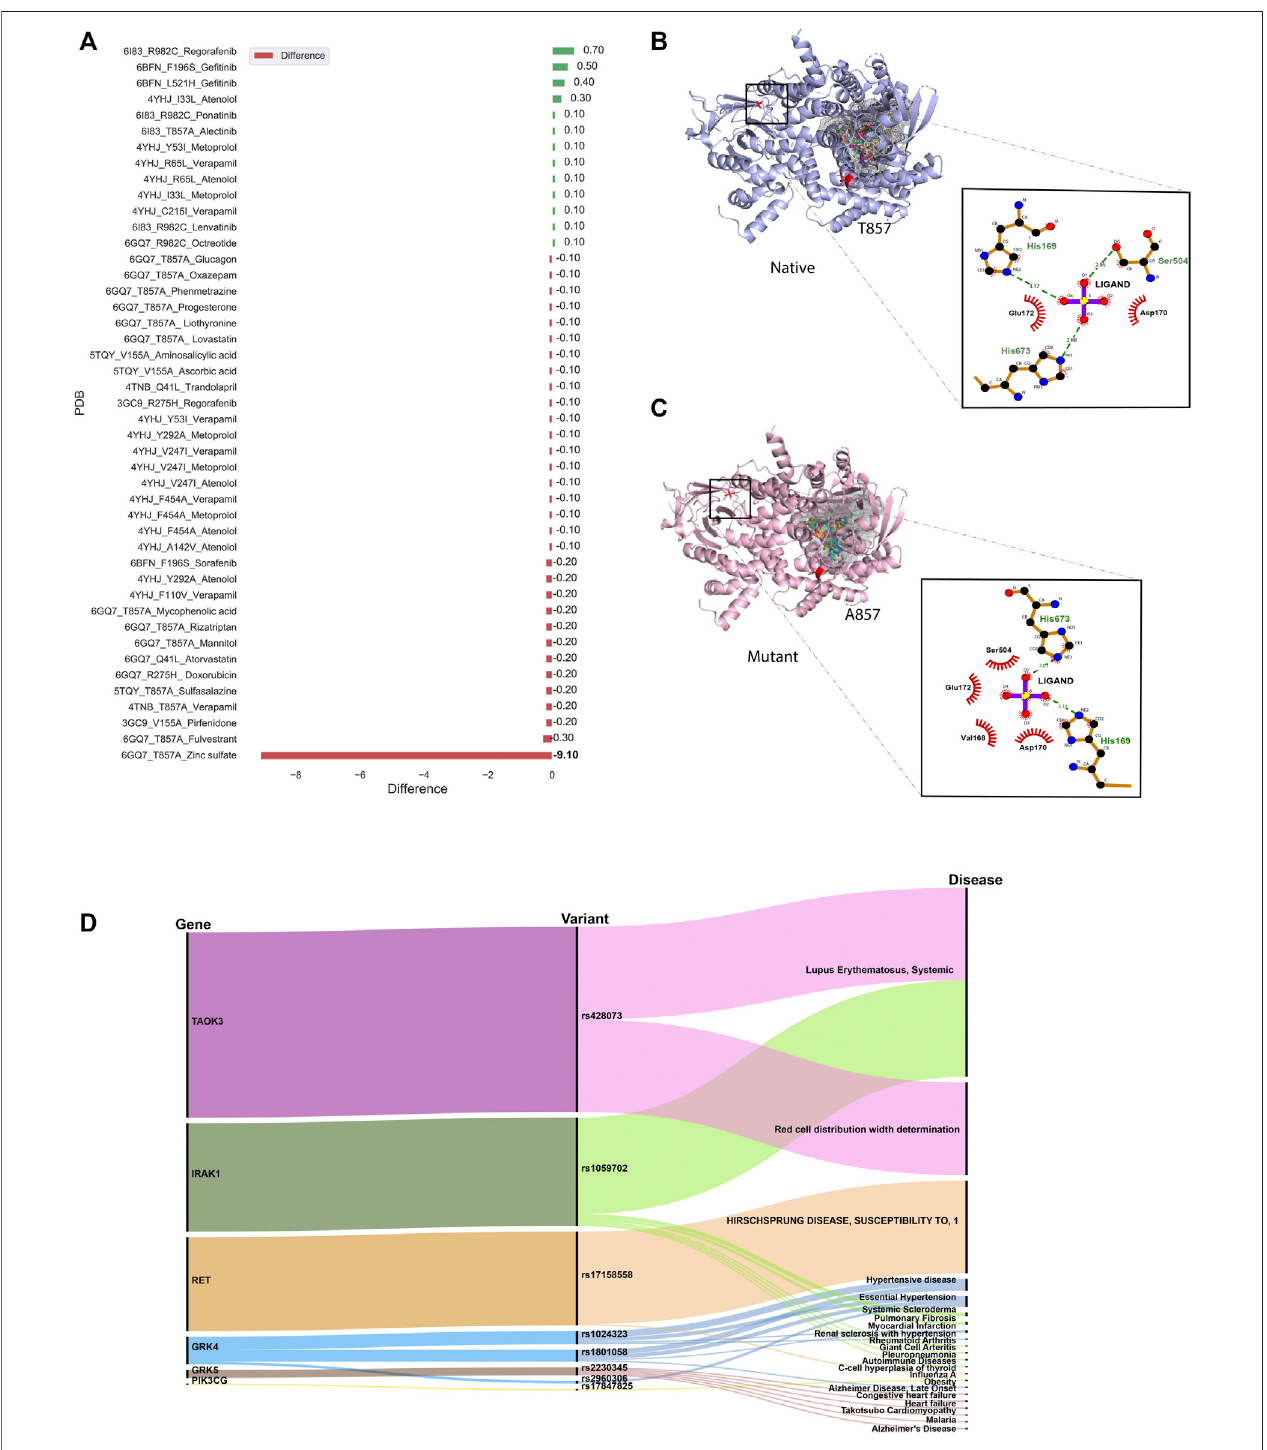
FIGURE5|(A) Barplotshowingdocking resultsfor45protein-drugpairs onthex-axis andchangeinbindingaf fi nityobservedonthey-axis.Redbars represent a decreaseinbindingaf fi nityandgreenbarsrepresentanincreaseinbindingaf fi nityaftermutation. (B) Ligandinteractiondiagramofnative6GQ7(PIK3CGgene)boundto Zinc Sulfate (DB09322) . (C) Ligand interaction diagram of mutant T857A of PIK3CG gene (PDB ID 6GQ7) bound to Zinc Sulfate (DB09322) and main binding pocket (grey colour) where the majority of ligands were docked. (D) An alluvial plot with showing association of genes, variants, and diseases, where the thickness of the variant-disease line is proportional to the VDA score obtained from DisGeNET.